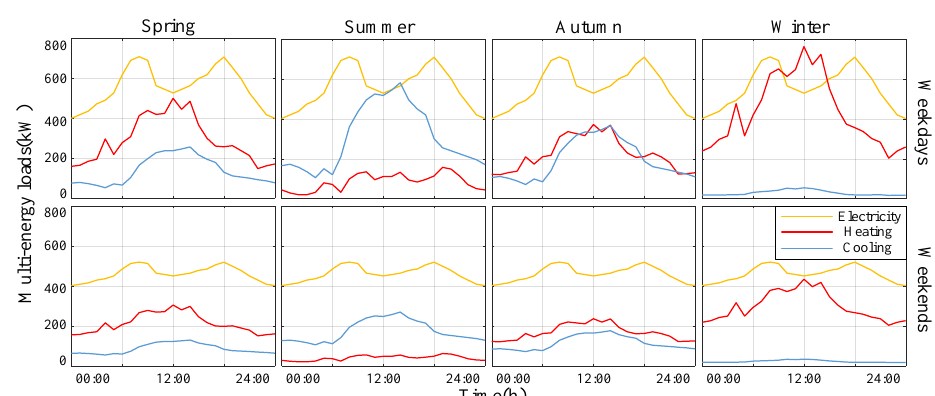
Figure A1. The electricity, heating and cooling loads for the EH in four seasons.